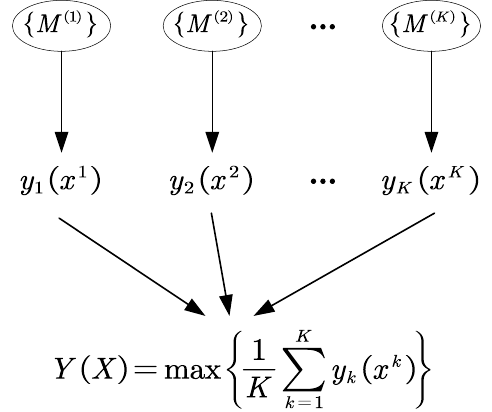
Figure 7. The fusion process of the soft voting